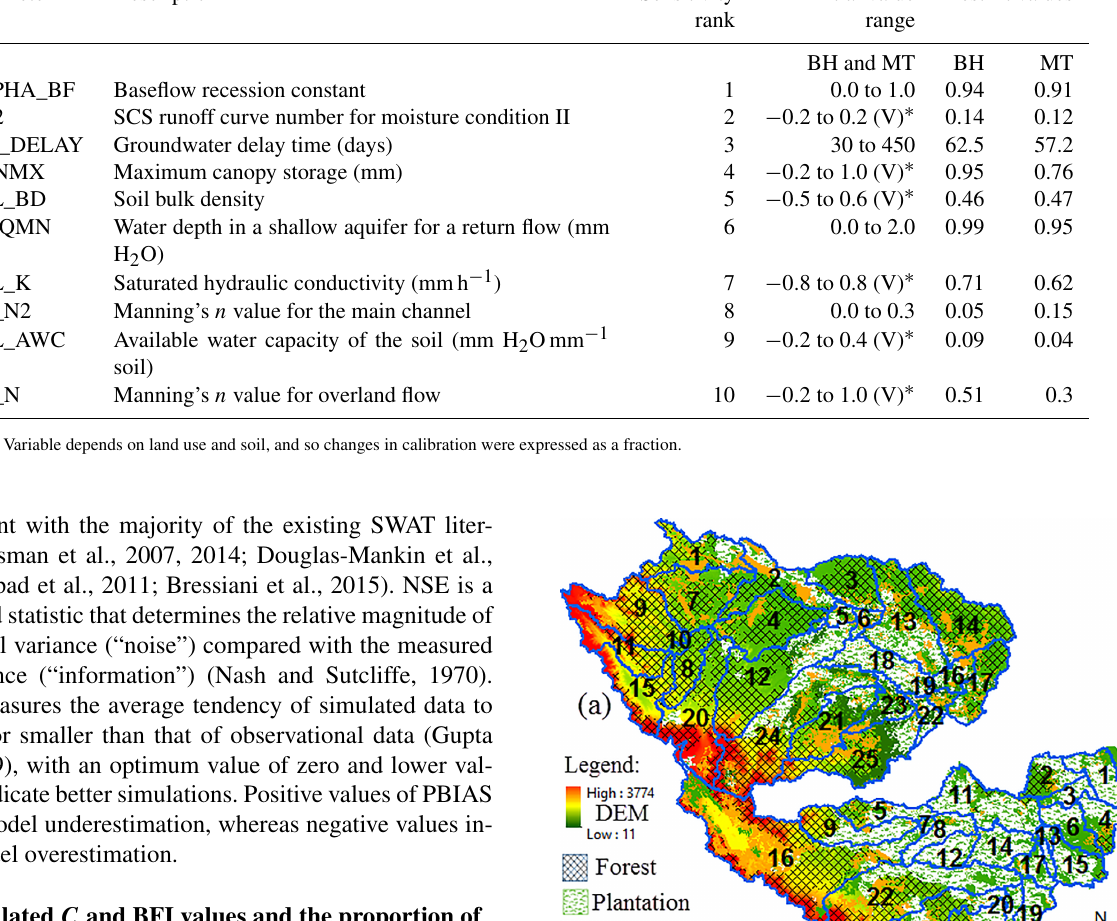
Table 7. Sensitivity rank and initial and final values of the calibration parameters that were used in the study for the BH and MT watersheds. Parameter Description Sensitivity